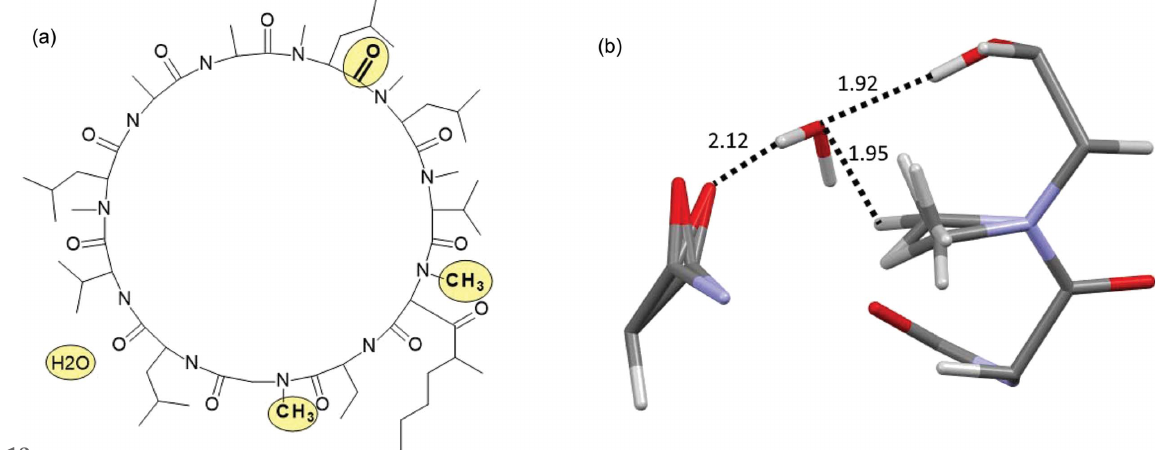
Figure 12 ( a ) Cyclosporine A hydrate: disordered sites are marked in yellow; ( b ) structure and interatomic distances between partially occupied atoms (in A˚